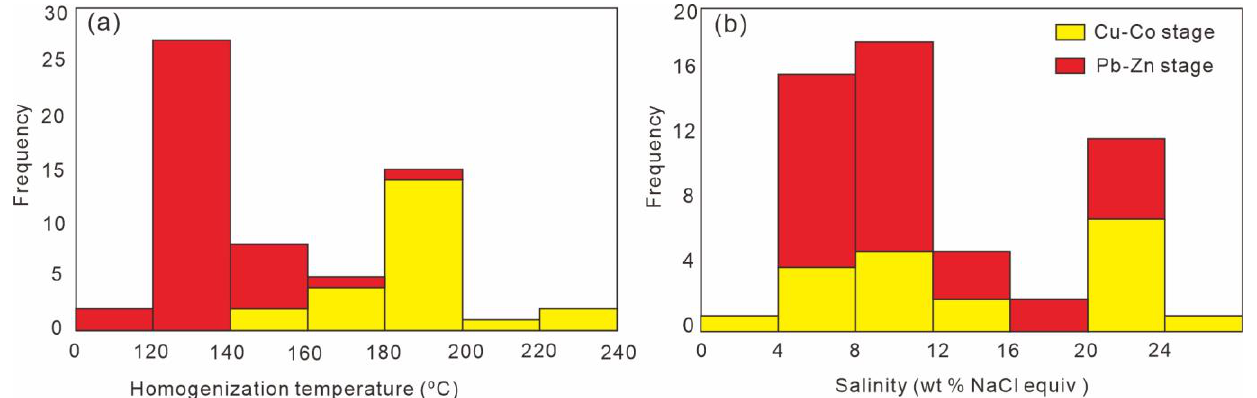
Figure 5. Homogenization temperature ( a ) and salinity ( b ) histograms for all of the inclusion types from two hydrothermal events at the Baiyangping Cu – Co – Pb – Zn deposit. Table 1. Carbon and oxygen isotopic compositions of carbonate minerals at the Baiyangping Cu–Co– Pb–Zn